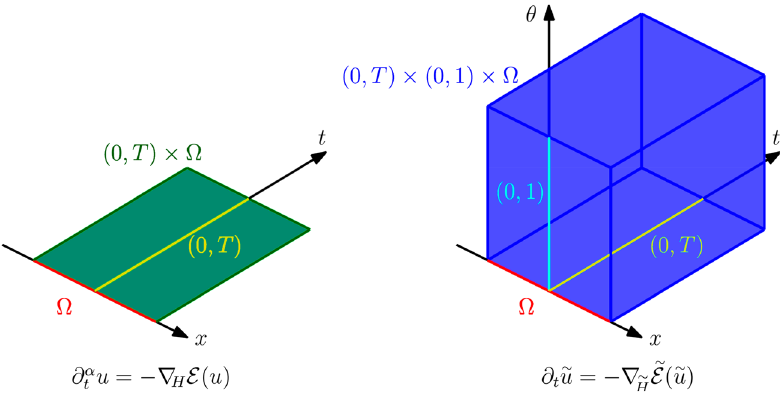
Figure 1: Left: Time - space domain ( ) × T 0, Ω of the function u . Right: Extended domain ( ) ( ) × × T 0, 0, 1 Ω of ∼